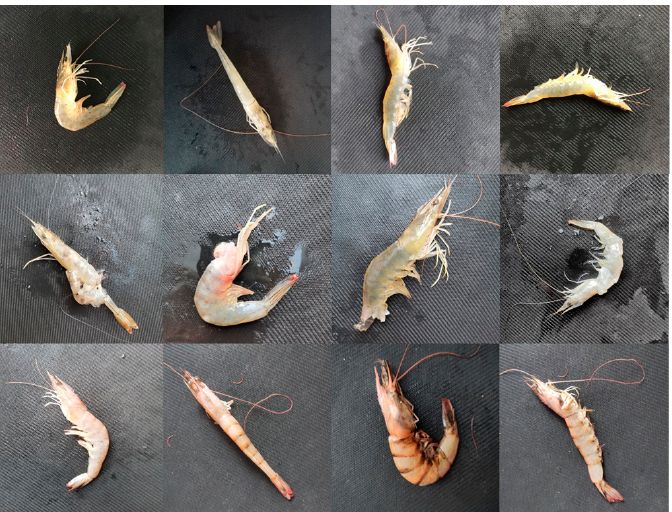
Figure 6. Starting from the first row, the order is normal shrimp, incomplete shrimp, and stale